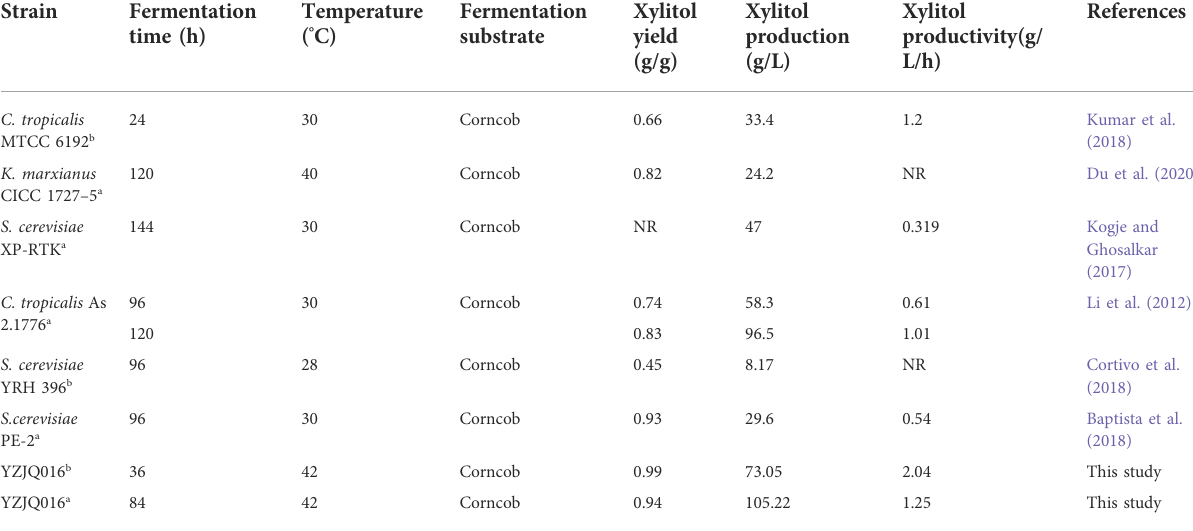
TABLE 4 Comparison of xylitol production of some yeast strains with corncob hydrolysate.